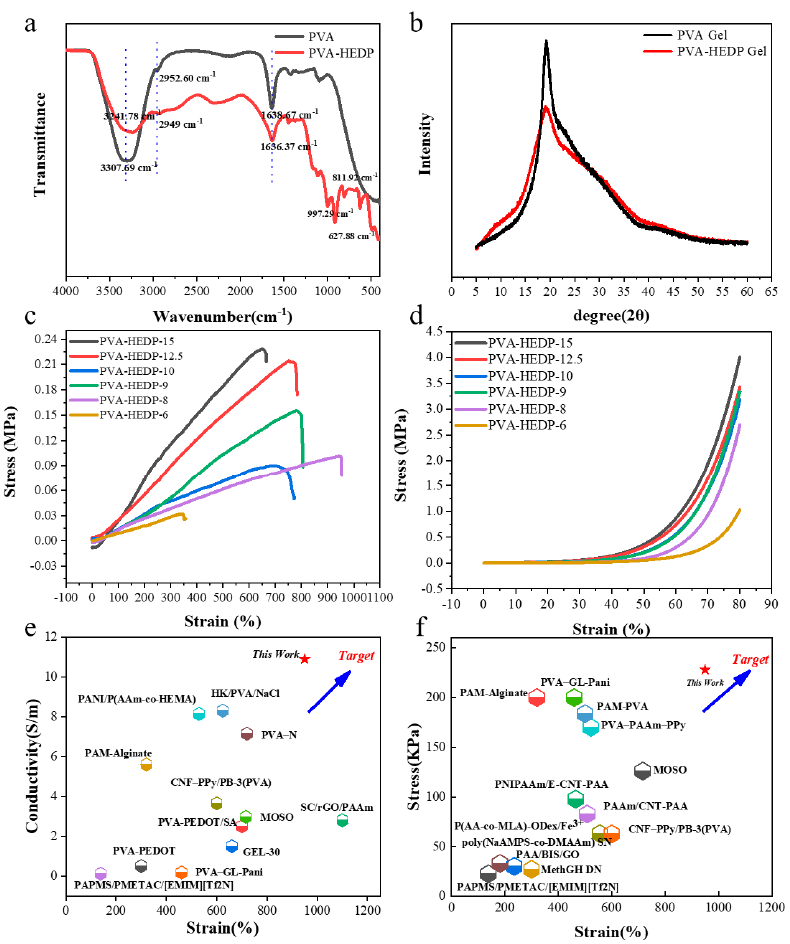
Figure 2. Characteristics of PVA-HEDP hydrogels. ( a ) FTIR spectra for the pure PVA gel and the PVA-HEDP gel. ( b ) XRD spectra for the pure PVA gel and the PVA-HEDP gel. ( c ) Stress–strain curves of the hydrogels with various HEDP contents. ( d ) Compressive stress–strain curves of the hydrogels with various HEDP contents. ( e , f ) Comparison of electrical and mechanical properties with previous research work [18 − 33].